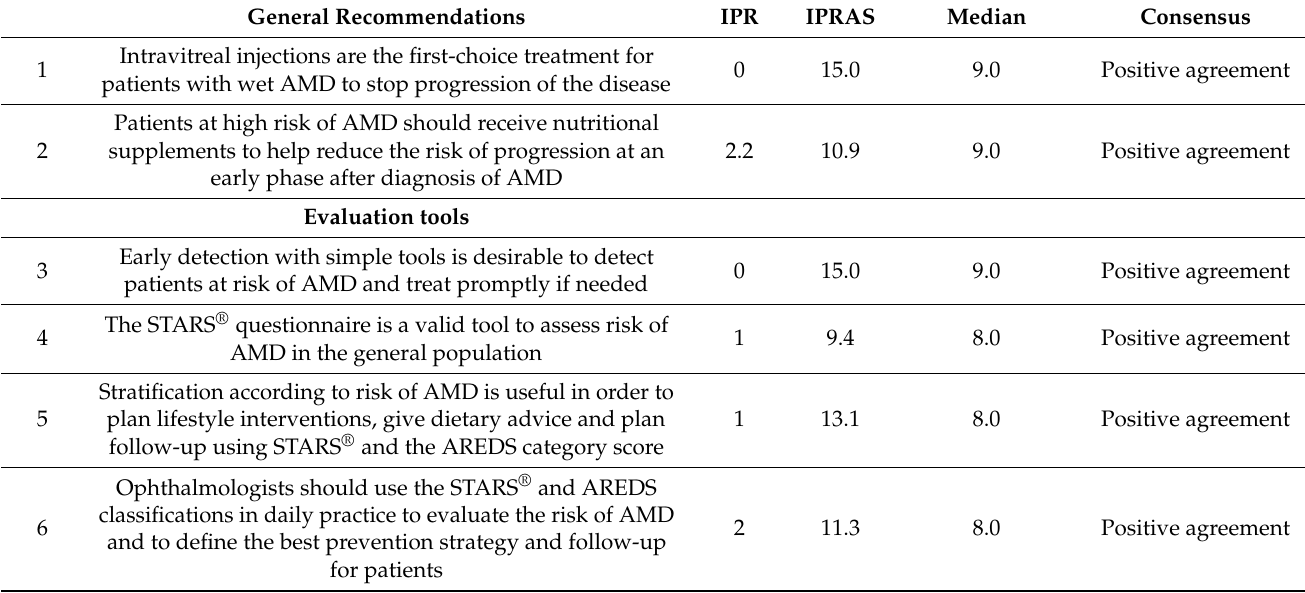
Table 1. Consensus statements on general issues, evaluation tools, general lifestyle advice, and AREDS-based supplementa-